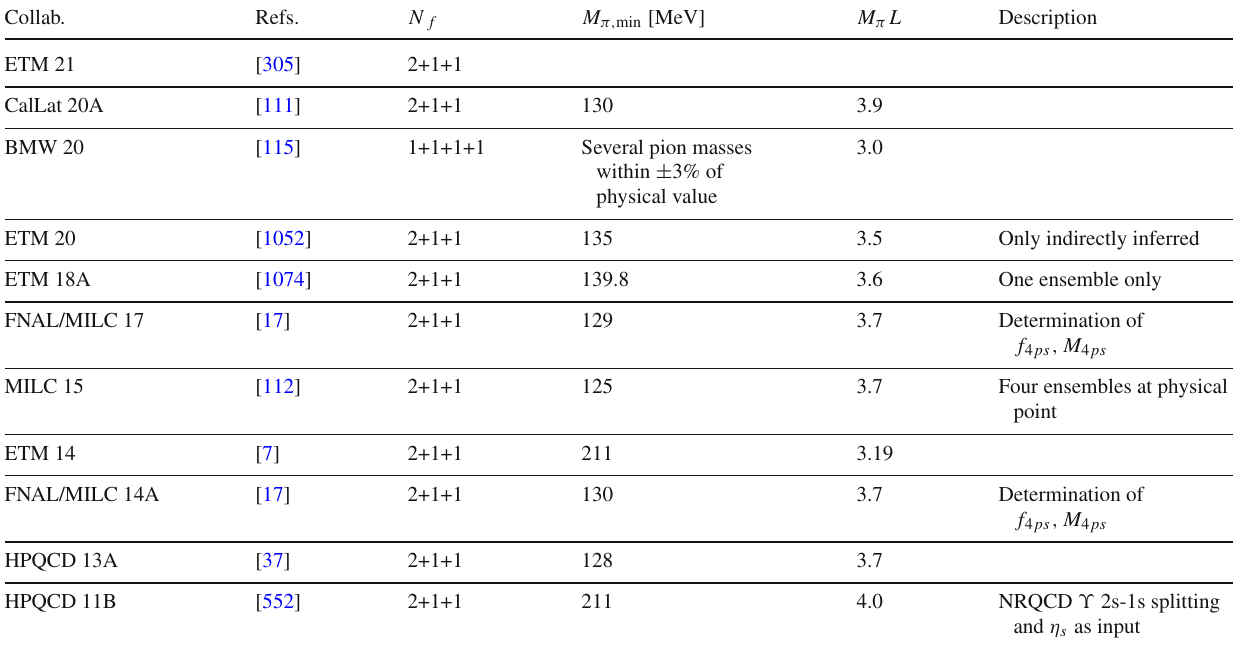
Table 199 Chiral extrapolation and finite-volume effects in scale determinations with N f = 2 + 1 + 1 quark flavours. We list the minimum